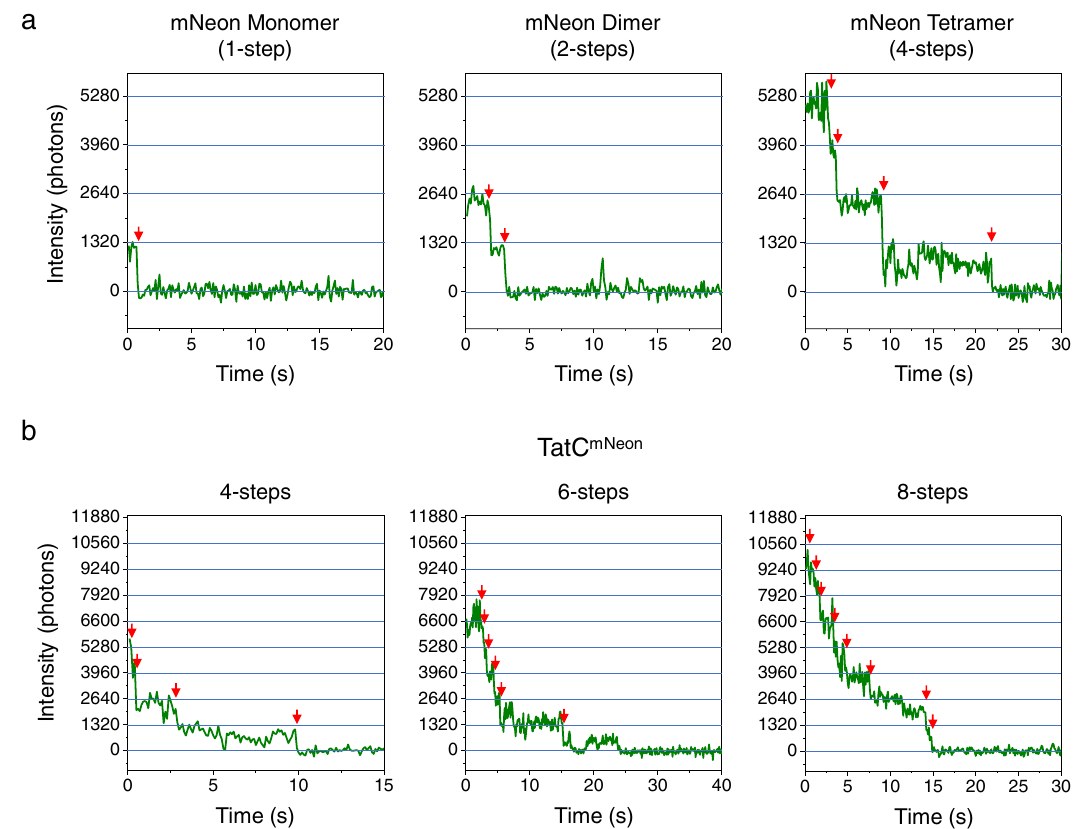
Fig. 4 Manual identi fi cation of mNeon photobleaching steps. a Sample photobleaching traces of mNeon standards, as identi fi ed in Fig. 3d. b Sample photobleaching traces of IMVs containing TatABC mNeon . For both a , b , steps are established at the times identi fi ed by the red arrows (manually identi fi ed). While blinking events occurred and caused deviations from regular steps, the combination of step-size and total intensity allowed the assignment of the total number of steps in the photobleaching traces. Individual traces were background subtracted and normalized to zero. Supplementary Fig. 9a demonstrates the linearity of photon counts with increasing oligomer size and that the average step was ~1320 photons (blue